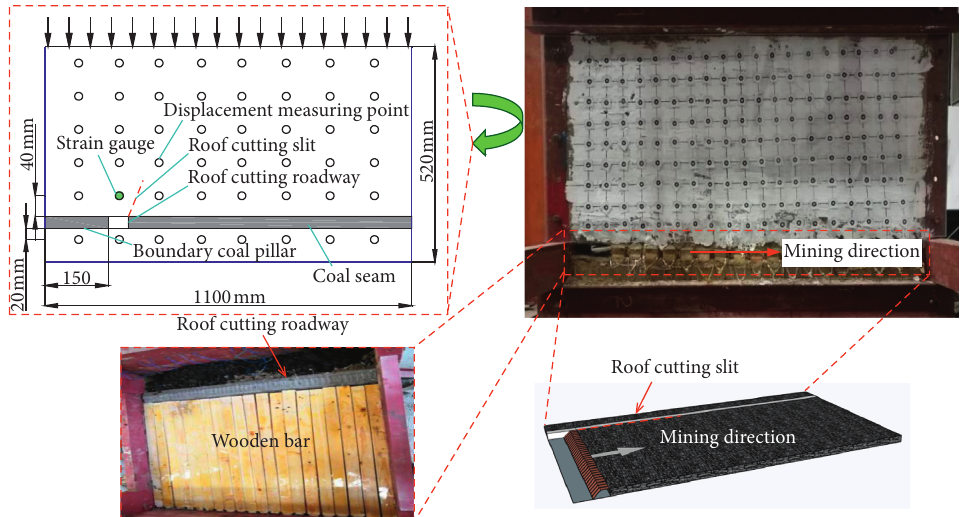
Figure 3: Layout of the coal seam excavation and measuring points.